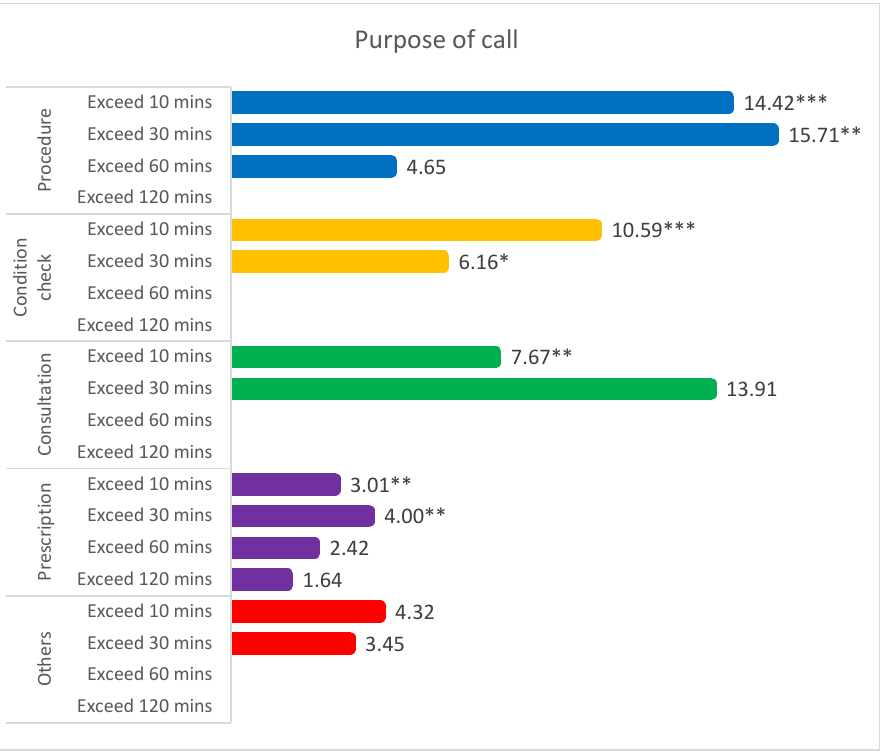
Table 5. Results of logistic regression analysis on the time to response a medical call of non-hospi- talist compared to hospitalists ⁺.